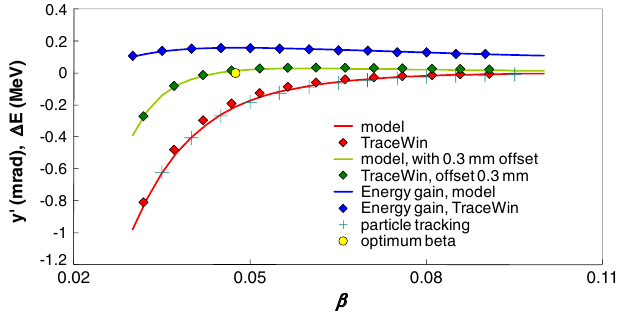
FIG. 5. Proton beam steering and energy gain at 1 MV = m , ¼ 0 : 047 , 80 MHz QWR calculated with (cid:2) ¼ (cid:1) 30 (cid:6) in a (cid:1) o analytical model (15) (lines), with particle tracking at constant (cid:1) (crosses), and with the 3D beam dynamics code TRACEWIN [11] (diamonds), on axis (red) and with 0.3 mm beam offset (green) which provides steering compensation. The (cid:1) values used for the TRACEWIN data are the average particle velocities in the